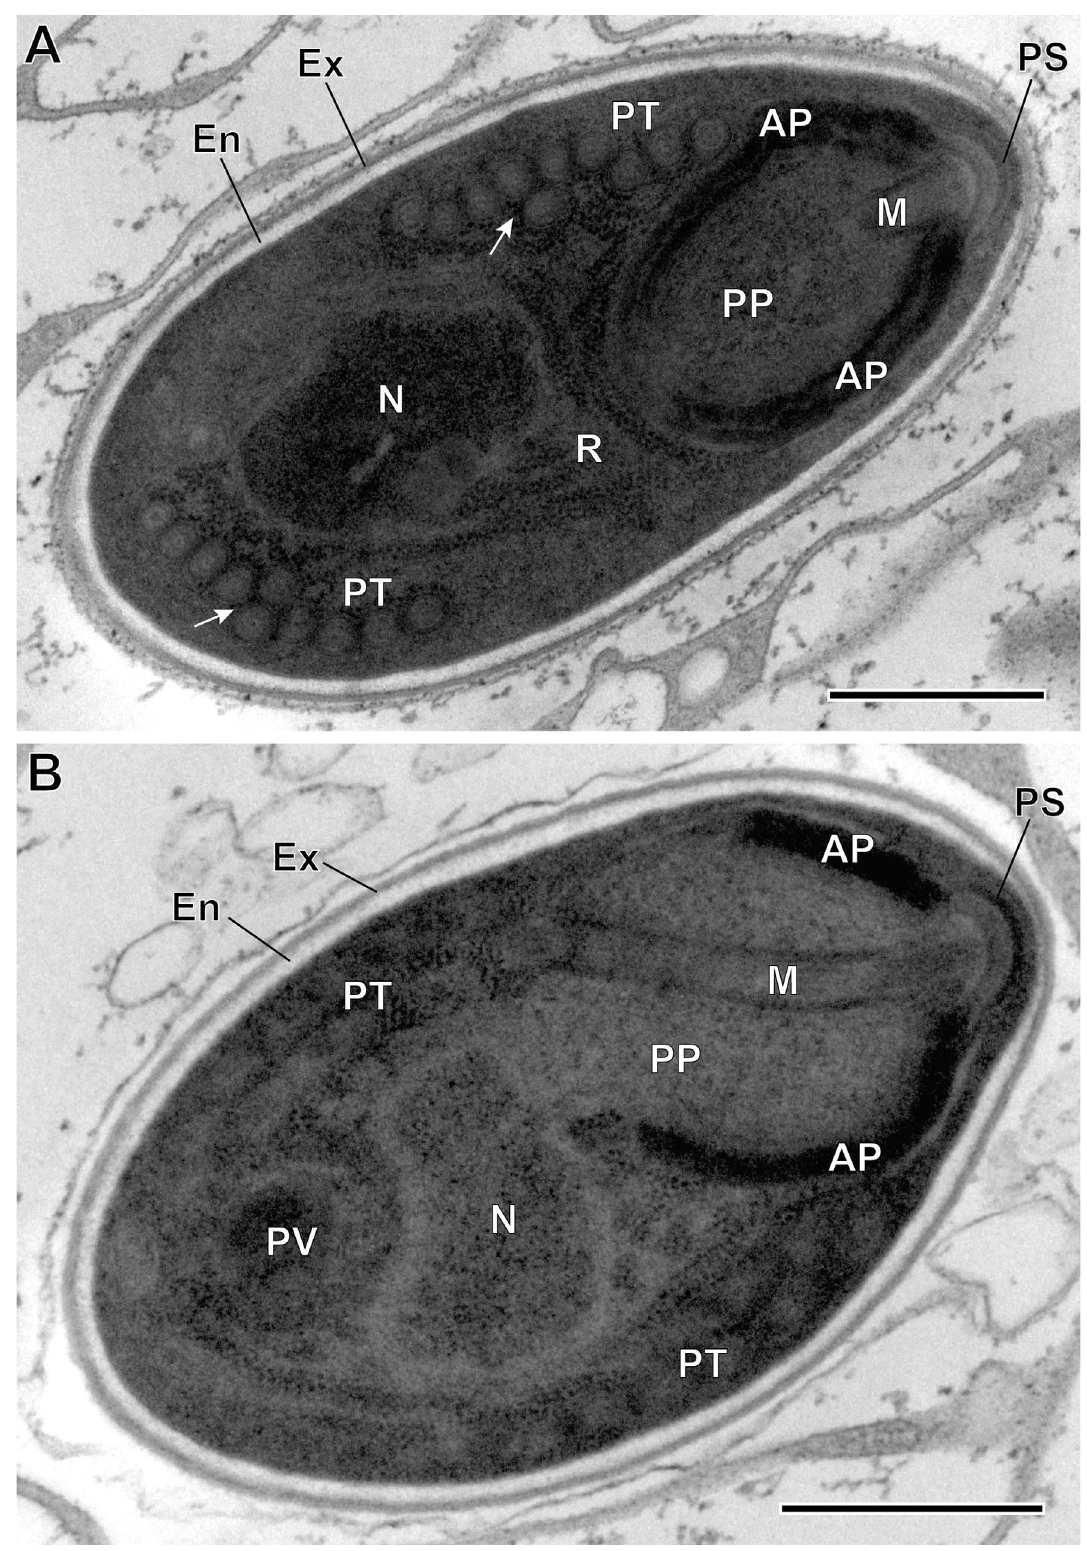
Figure 7. (A – B) Ultrastructural details of mature spores of Toguebayea baccigeri n. gen., n. sp observed in longitudinal ultrathin sections. The polar tube (PT) coils are arranged in two rows slightly overlapping each other (white arrows). AP, anterior polaroplast; En, endospore; Ex, exospore; M, manubrium; N, nucleus; PP, posterior polaroplast; PS, polar sac; PV, posterior vacuole; R, ribosomes and polyribosomes. Scale bars = 0.5 l